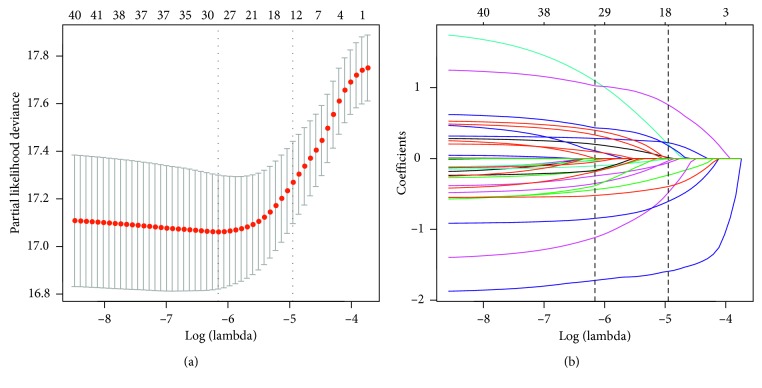
Selection of predictors using the LASSO regression analysis with 10-fold cross-validation. (a) Tuning parameter (lambda) selection of deviance in the LASSO regression based on the minimum criteria (left dotted line) and the 1-SE criteria (right dotted line). (b) A coefficient profile plot was produced against the log (lambda) sequence. In the present study, predictor's selection was according to the 1-SE criteria (right dotted line), where 11 nonzero coefficients were selected. SE, standard error.